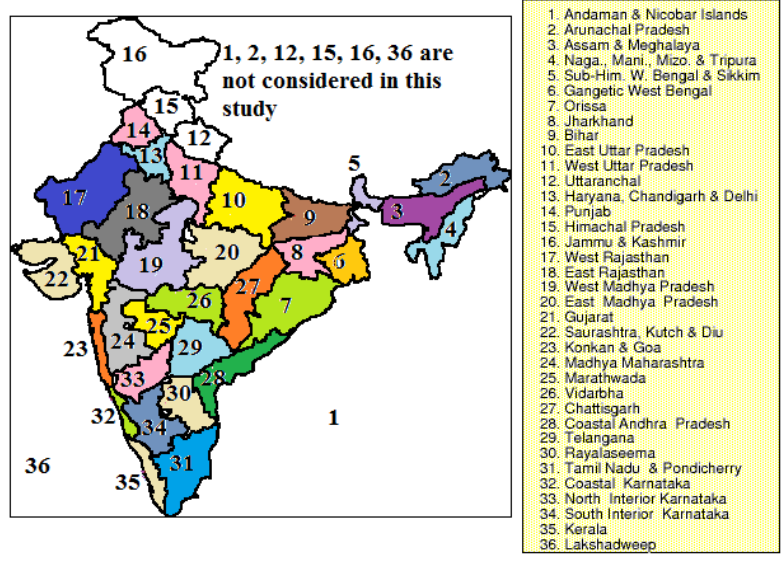
Figure 1. Details of Indian meteorological